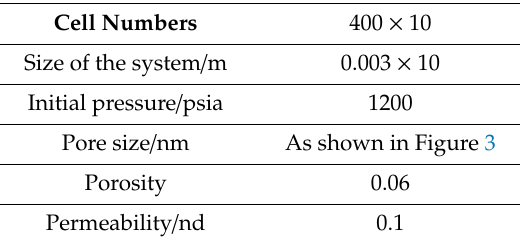
Table 1. Properties of the fracture–matrix 2D setup.